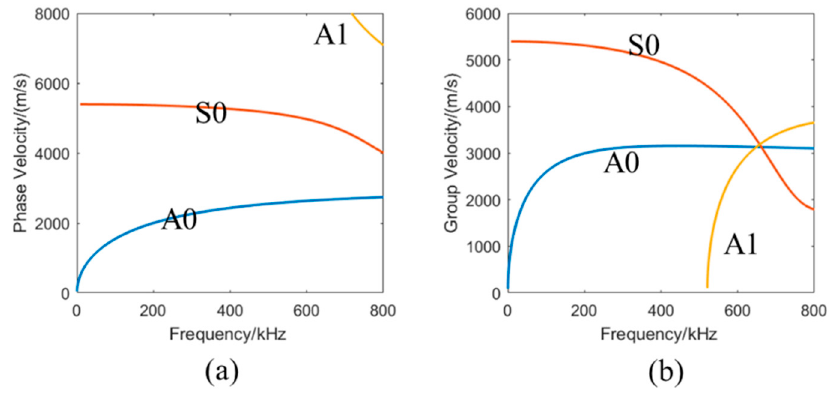
Figure 2. Dispersion curves of the 3 mm isotropic aluminum plate: ( a ) phase velocity; ( b ) group velocity.